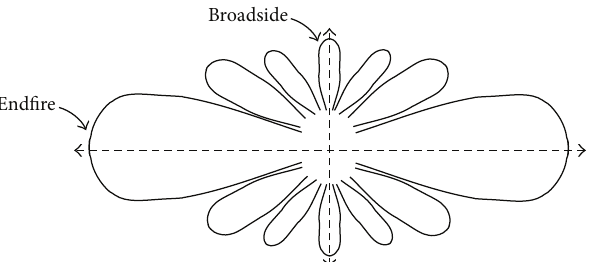
Figure 12: Uncertainty of linear array has distinctive pattern and is much greater towards the endfire.